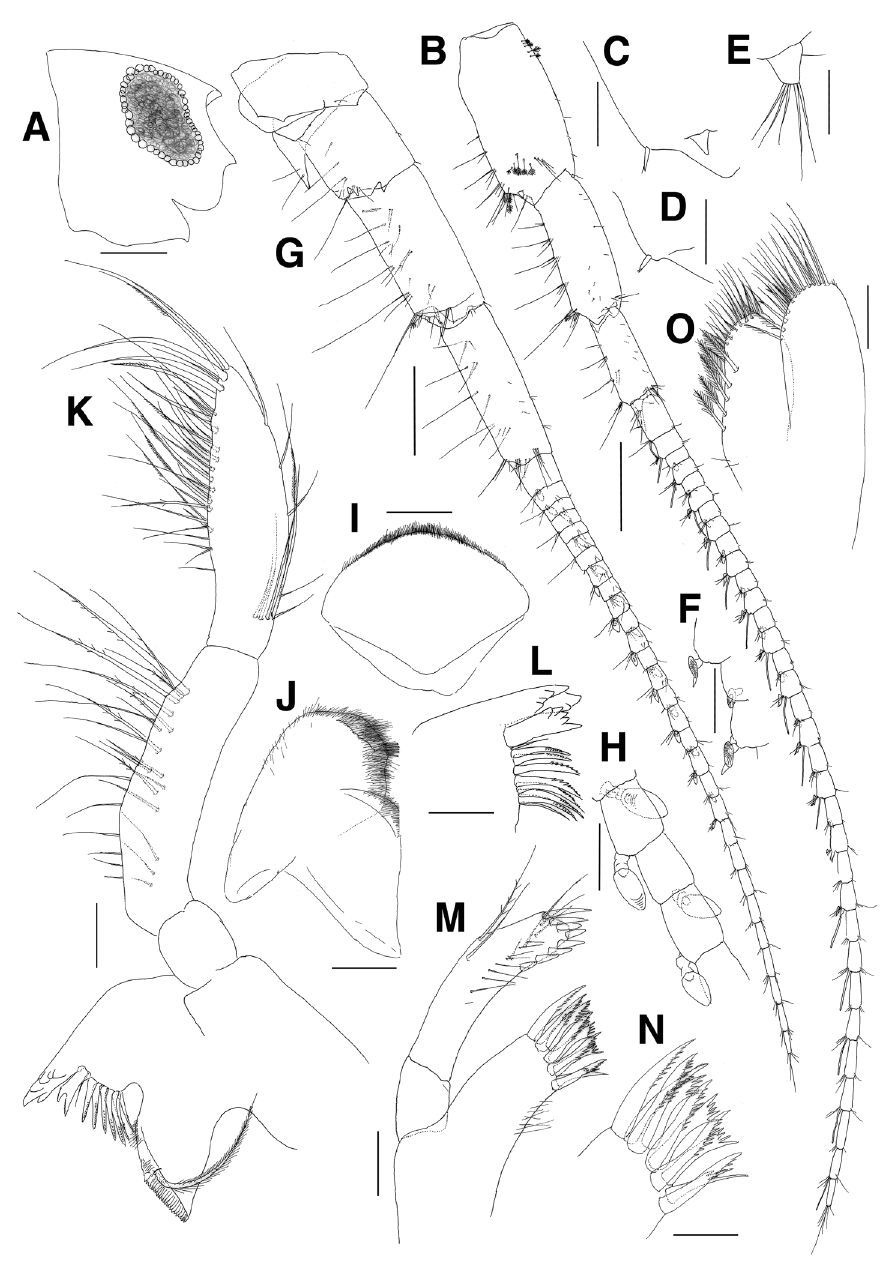
Figure 7. Paramoera dentipleurae sp. n., holotype. A Head B Antenna 1 C Posterodistal part of pedun- cular article 1 on antenna 1 D Posterodistal part of peduncular article 2 on antenna 1 E Accessory flagel- lum F Calceoli of flagellum on antenna 1 G Antenna 2 H Calceoli of flagellum on antenna 2 I Upper lip J Lower lip K Right mandible L Left mandible M Maxilla 1 N Dentate apical setae of outer plate on maxilla 1 O Maxilla 2. Scale bars 0.05 mm ( C–F, H–M, O ), 0.1 mm ( N ), 0.2 mm ( A, B, G